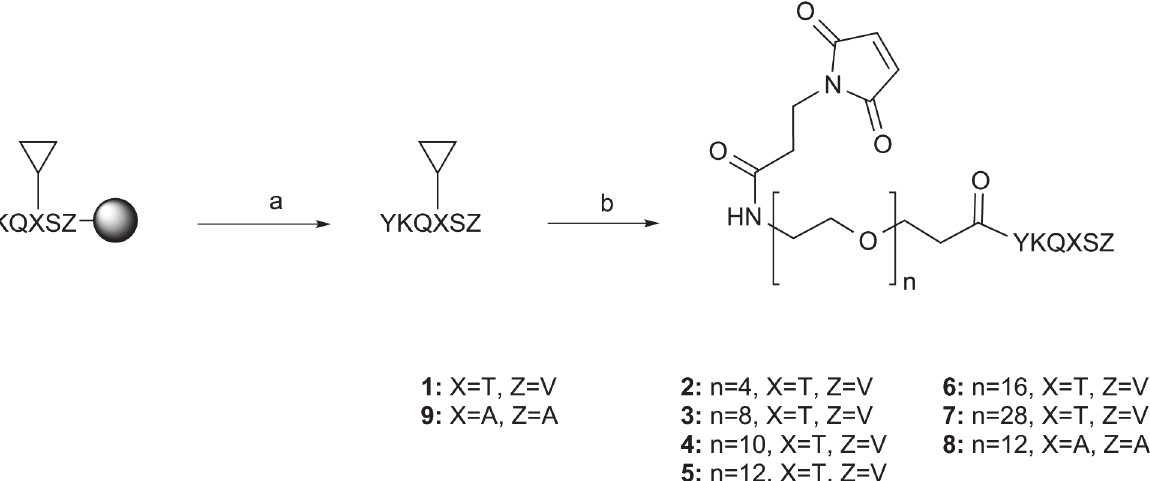
Fig 2. Synthesis of building blocks 1 − 9. Reaction conditions: (a) HFIP, DCM (2 x 5 min); (b) malonylpropionyl-PEG(n)-O-PfP or malonylpropionyl-PEG(n)- O-NHS, DIPEA, HOAt, DMF, DCM, then TFA,TiPS, H2O (90:5:5). 5 = fully side-chain protected peptide. Single letters designate amino acids except for N (nitrogen), O (oxygen) and H